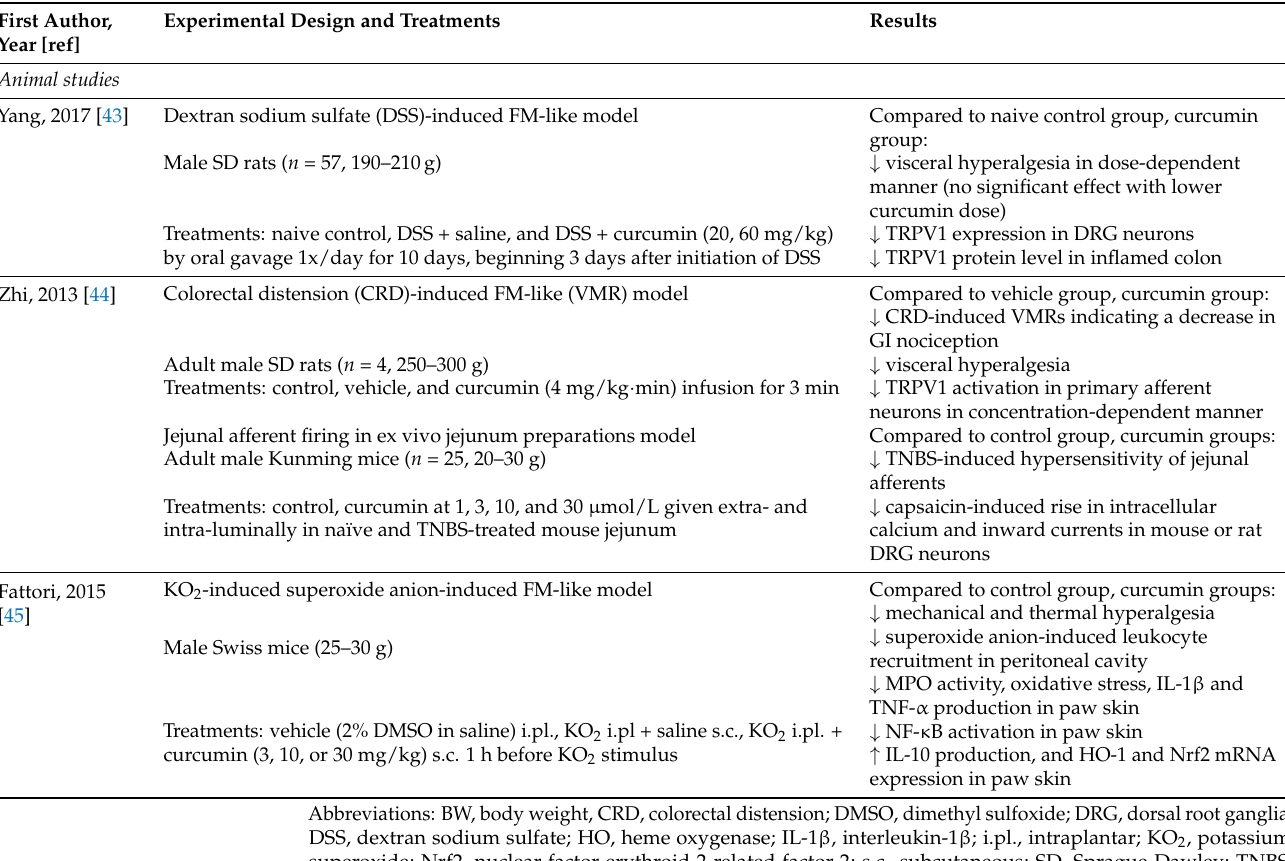
Table 3. Effects of curcumin on fibromyalgia-like symptom in animal